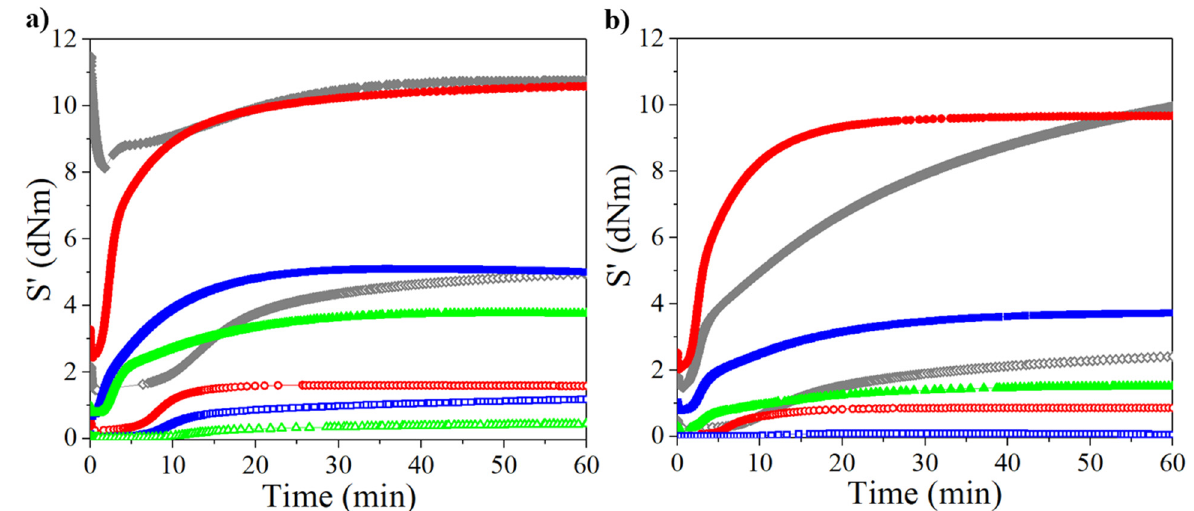
Figure 2. Rheometric curves for crosslinked rubbers through CV at 160 °C for high- ( a ) and low- molecular-weight ( b ) rubbers (open and filled symbols represent unreinforced and reinforced rubbers, respectively). Legend: diamonds → PB, circles → PI, squares → PM, triangles → PF.